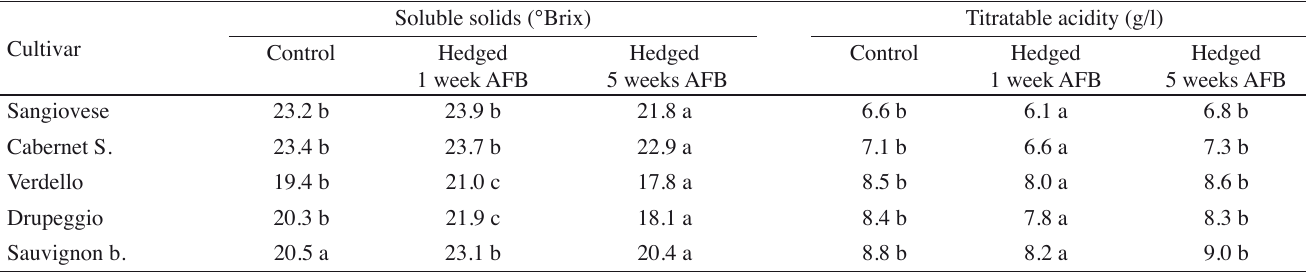
Table 6 - Soluble solids content and titratable acidity at harvest in different grapevine cultivars hedged one and five weeks after full bloom (AFB) and control